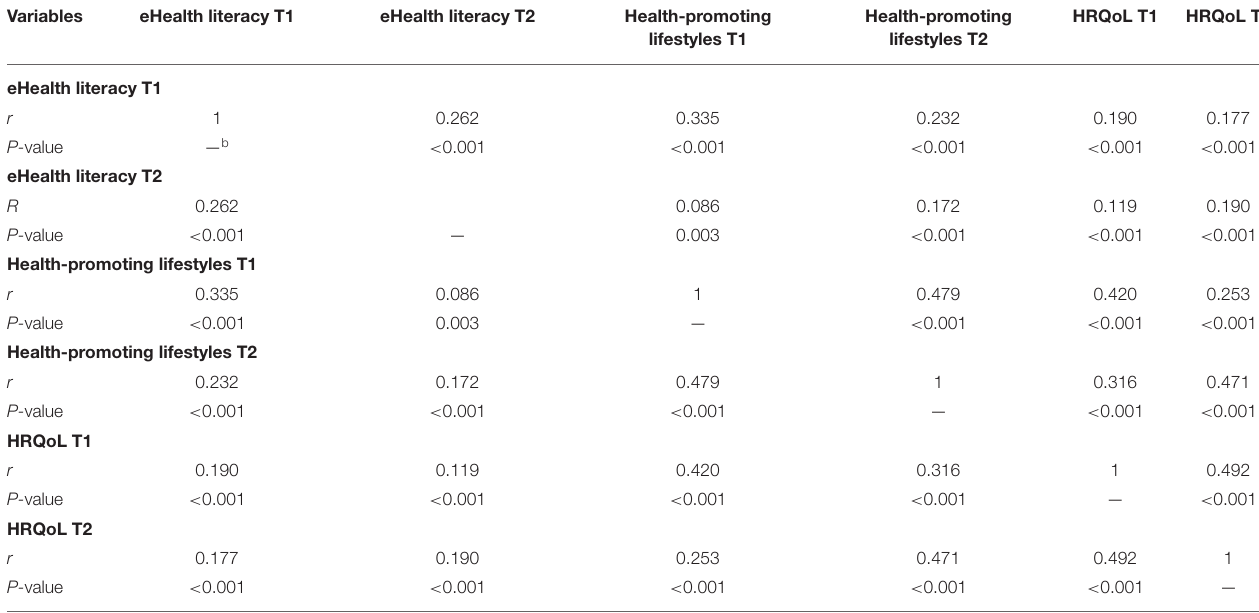
TABLE 2 | Correlation matrix (Pearson r and two-tailed P -value a ) of eHealth literacy, health-promoting lifestyles and HRQoL at two time-points.